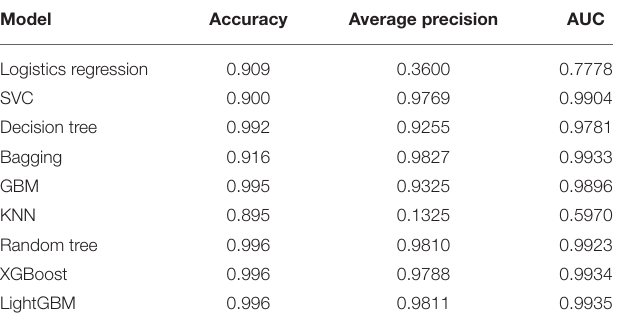
TABLE 4 | Comparisons of nine different machine learning